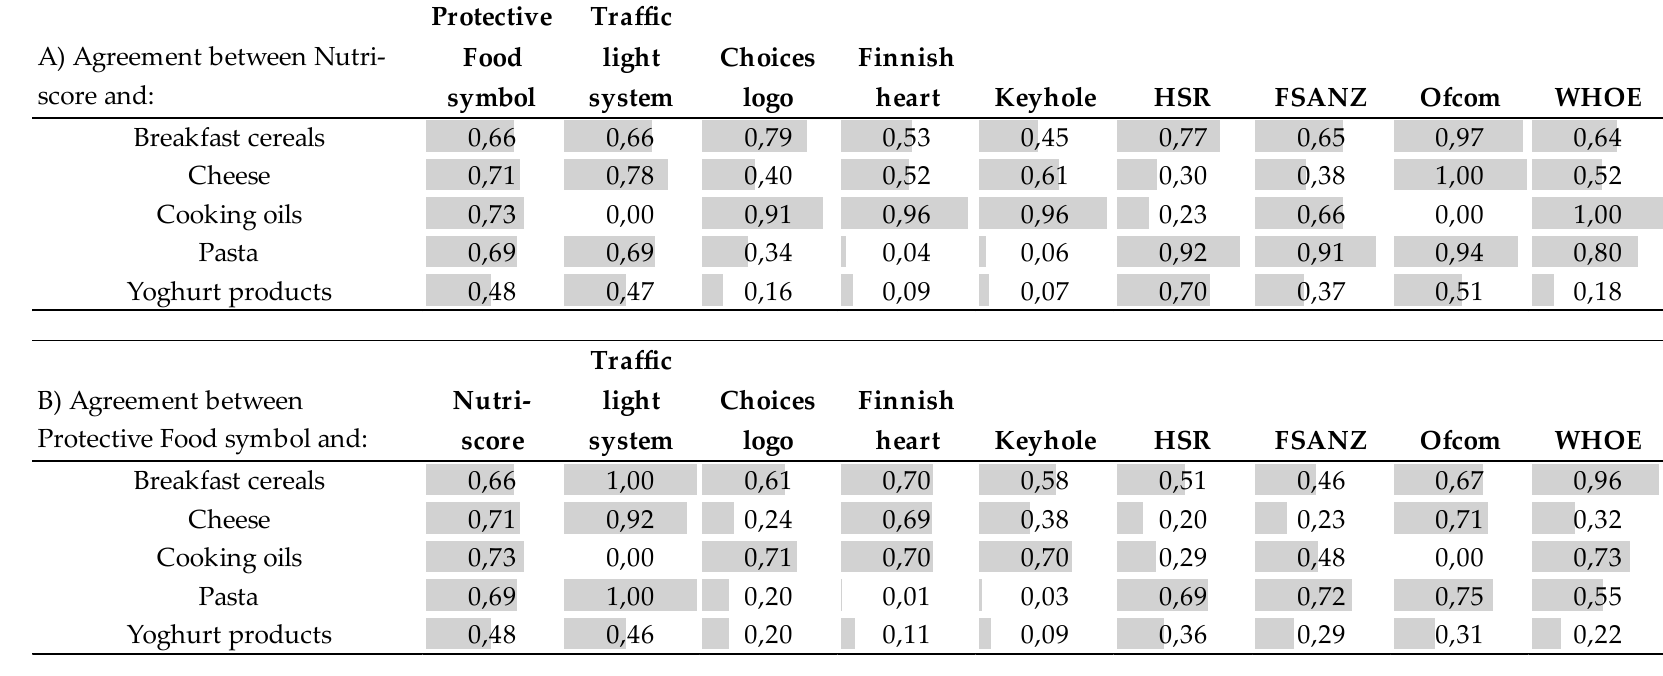
Figure 2. Agreement of ( a ) Nutri-Score or ( b ) Protective Food symbol with other nutrient-profiling models by Cohens kappa.